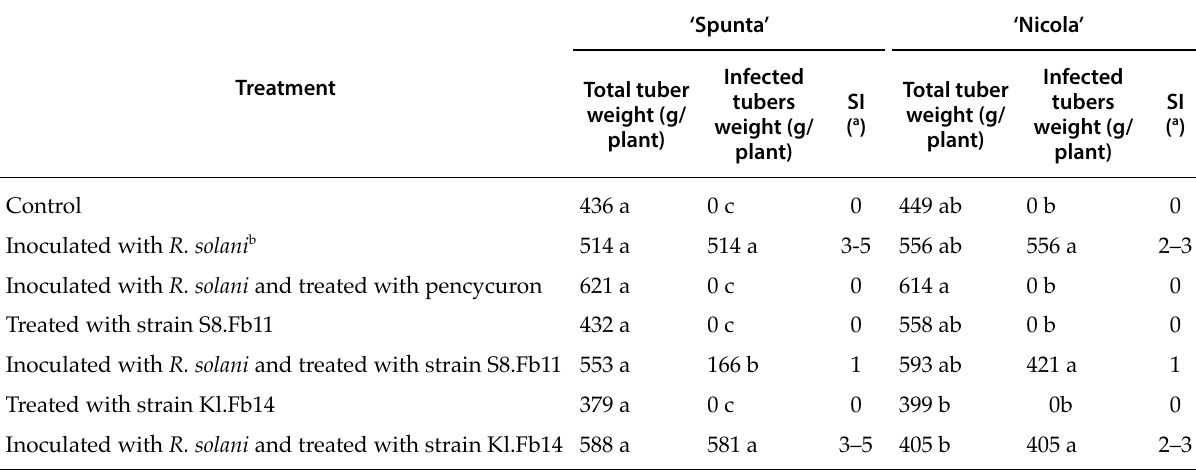
Table 3. Mean tuber weights, weights of infected tubers and disease severity scores for potato plants (‘Spunta’ and ‘Nicola’) grown after different Rhizoctonia solani , bacterial strain or fungicide combination treatments were applied in a greenhouse